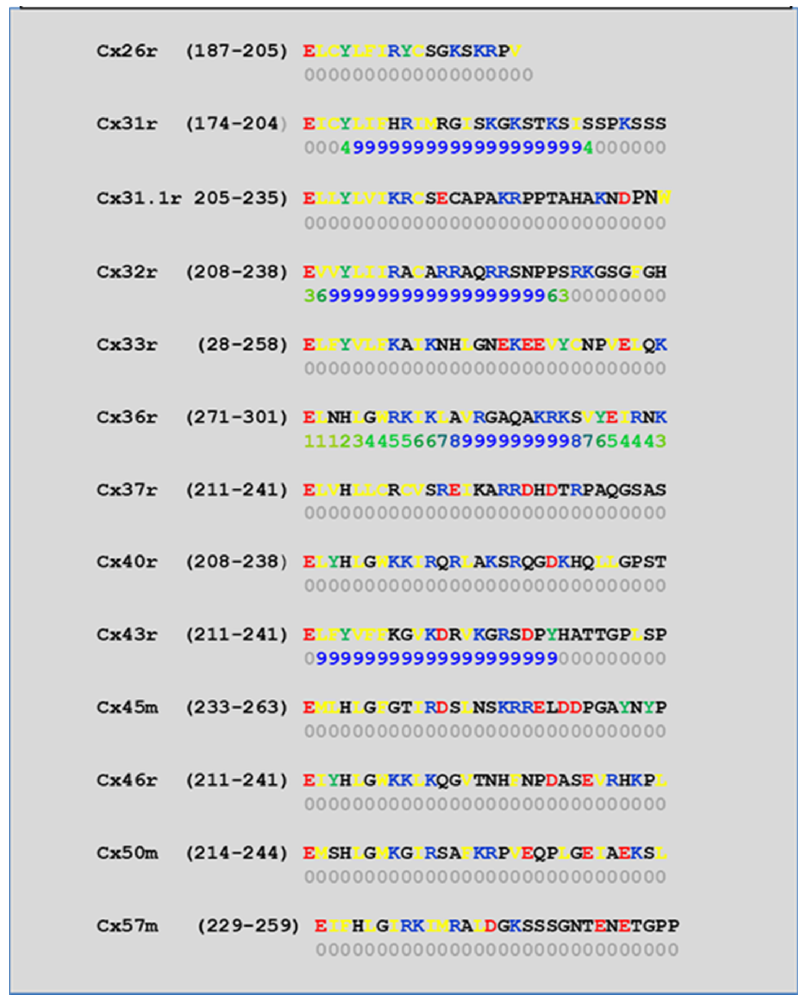
Figure 6. Predicted CaM-binding Site at CT1 Domain.